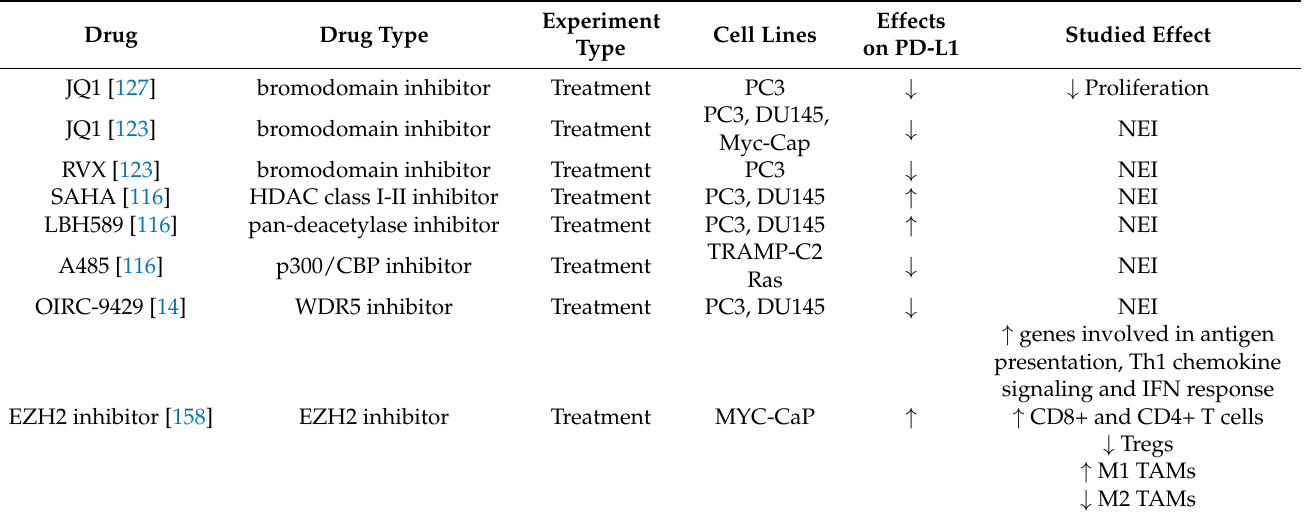
Table 2. Experimental treatments with epigenetic